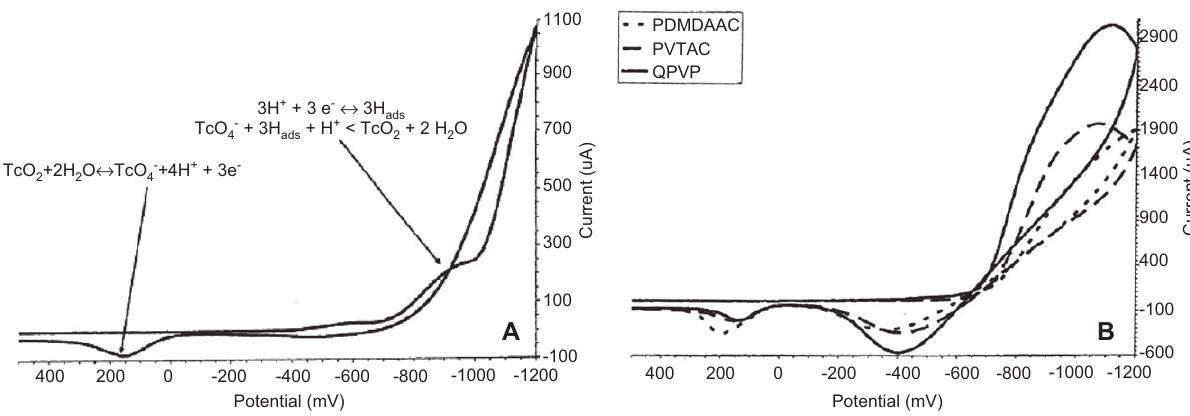
- ) in pH 7 phosphate buffer as supporting electrolyte, 25 mVs -1 scan rate, Ag/AgCl 4